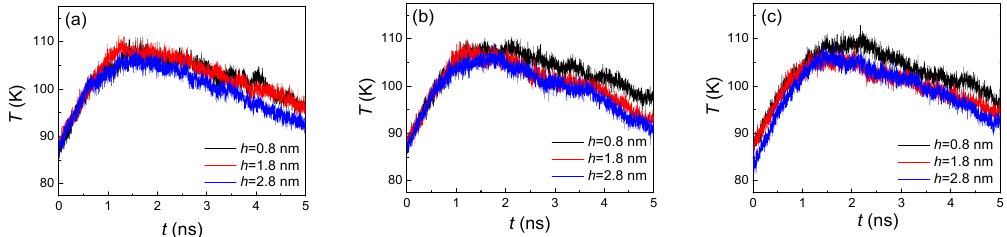
Figure 4. The temperature of argon atoms with three groove heights; from left to right, the groove widths are ( a ) 1.8, ( b ) 2.4, and ( c ) 3.2 nm on hydrophilic surfaces.